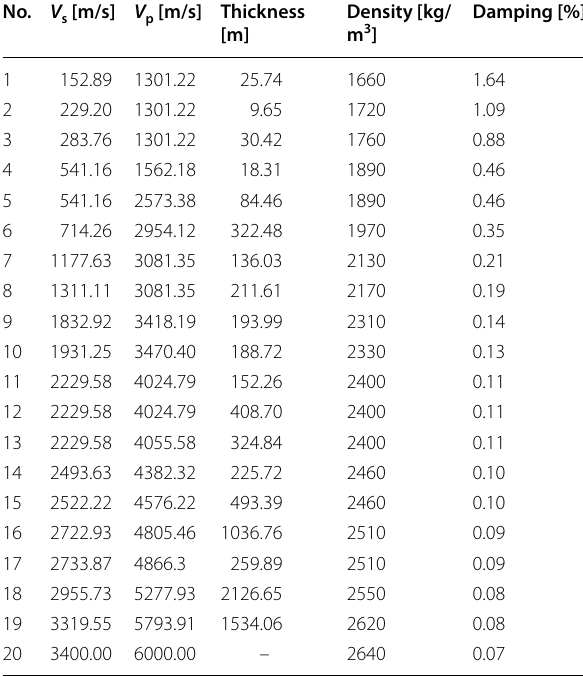
Table 3 Identified velocity structures for EHVR at KUMA No. V s [m/s] V p [m/s] Thickness [m]